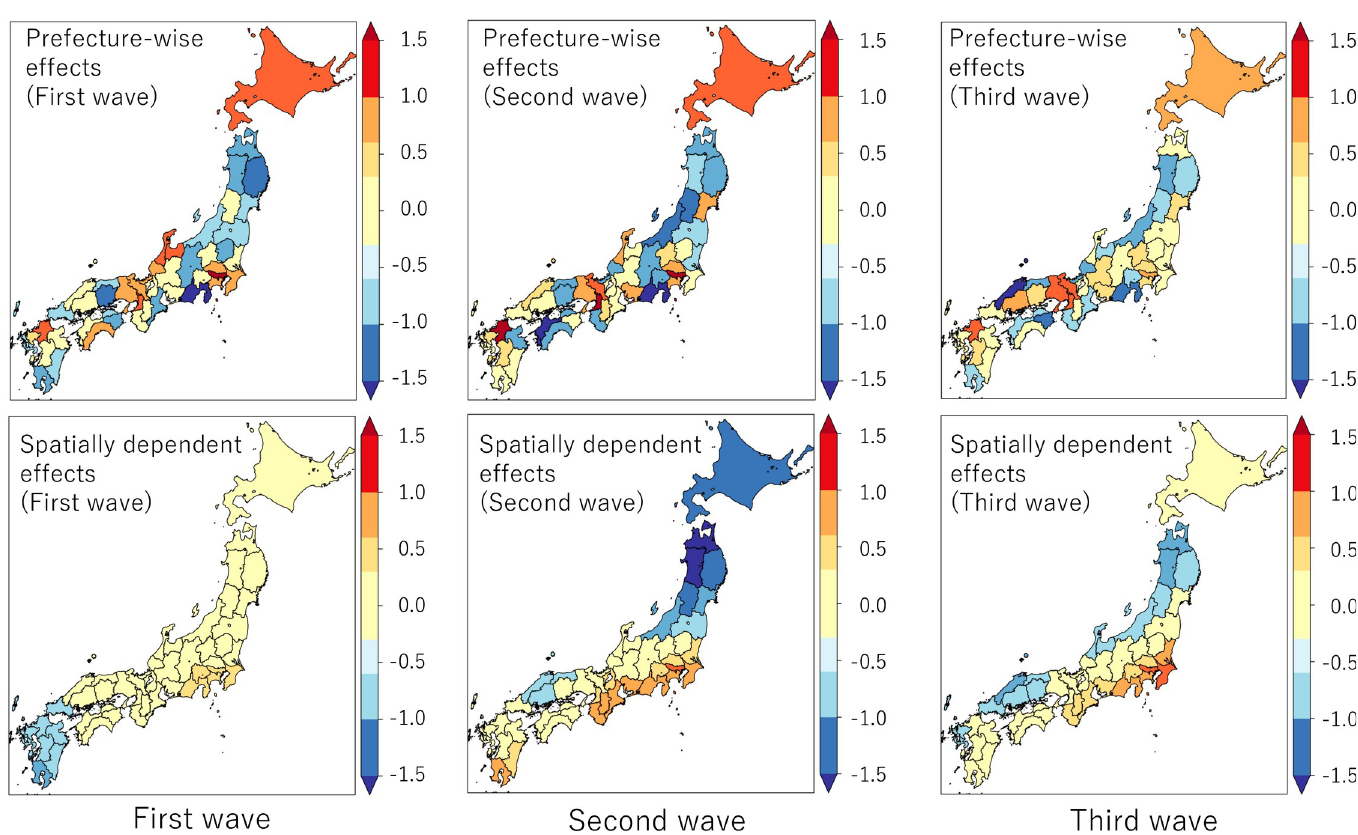
Fig 17. Estimated group effects by prefecture (top) and spatially dependent effects (bottom).